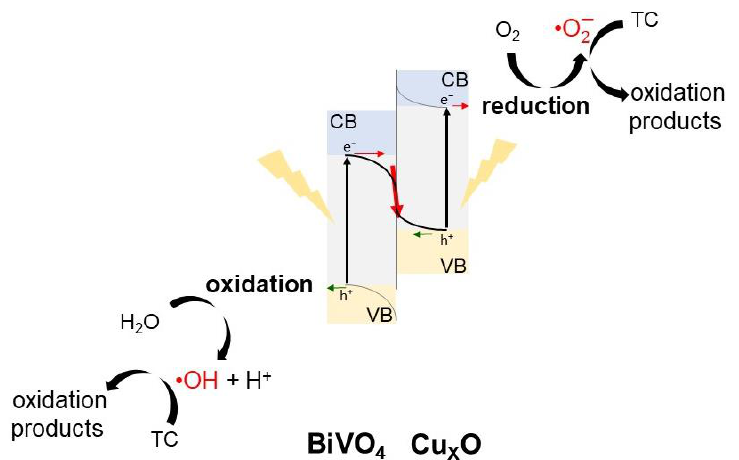
Figure 10. Schematic drawing of proposed Z-scheme mechanism for TC oxidation on Cu/BVO pho- tocatalyst.